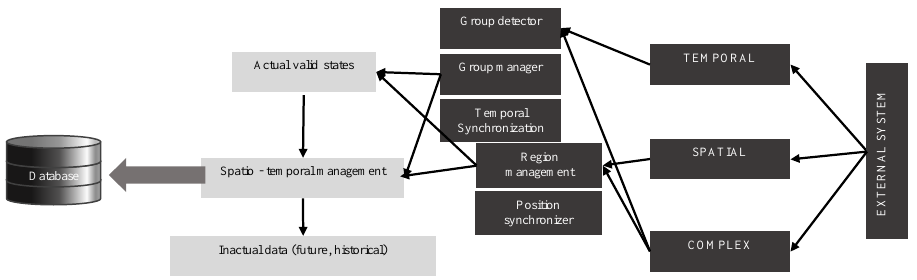
Figure 7. Spatio-temporal grouping.